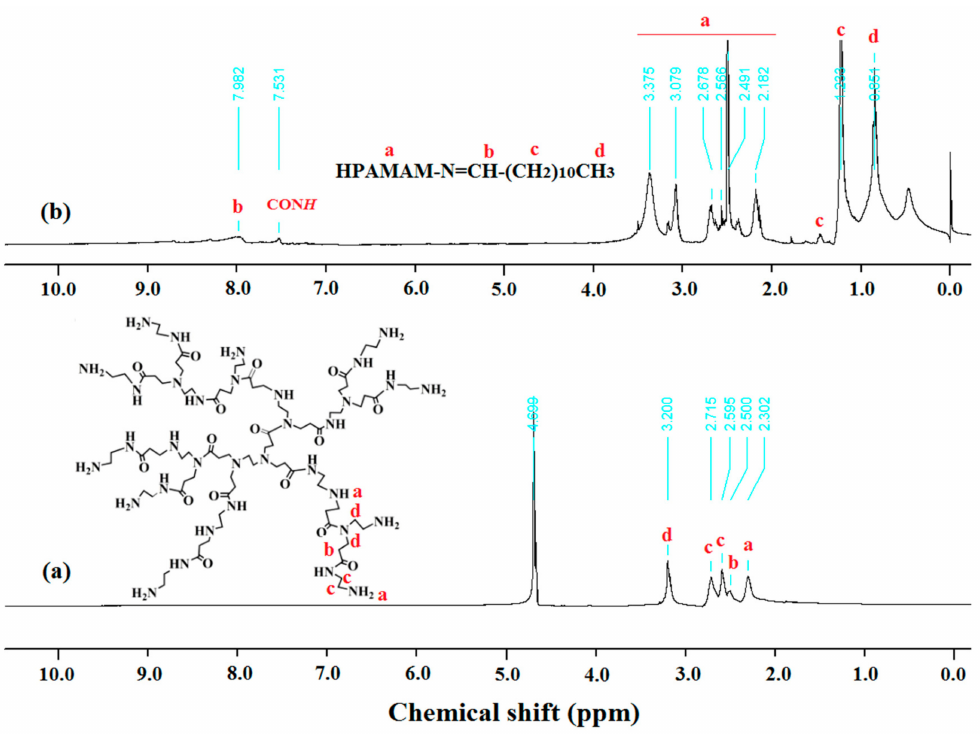
Figure 1. NMR spectra of ( a ) HPAMAM (400 MHz, in D 2 O, 298 K) and ( b ) HPAMAM–DA (400 MHz, in CDCl 3 , 298 K).